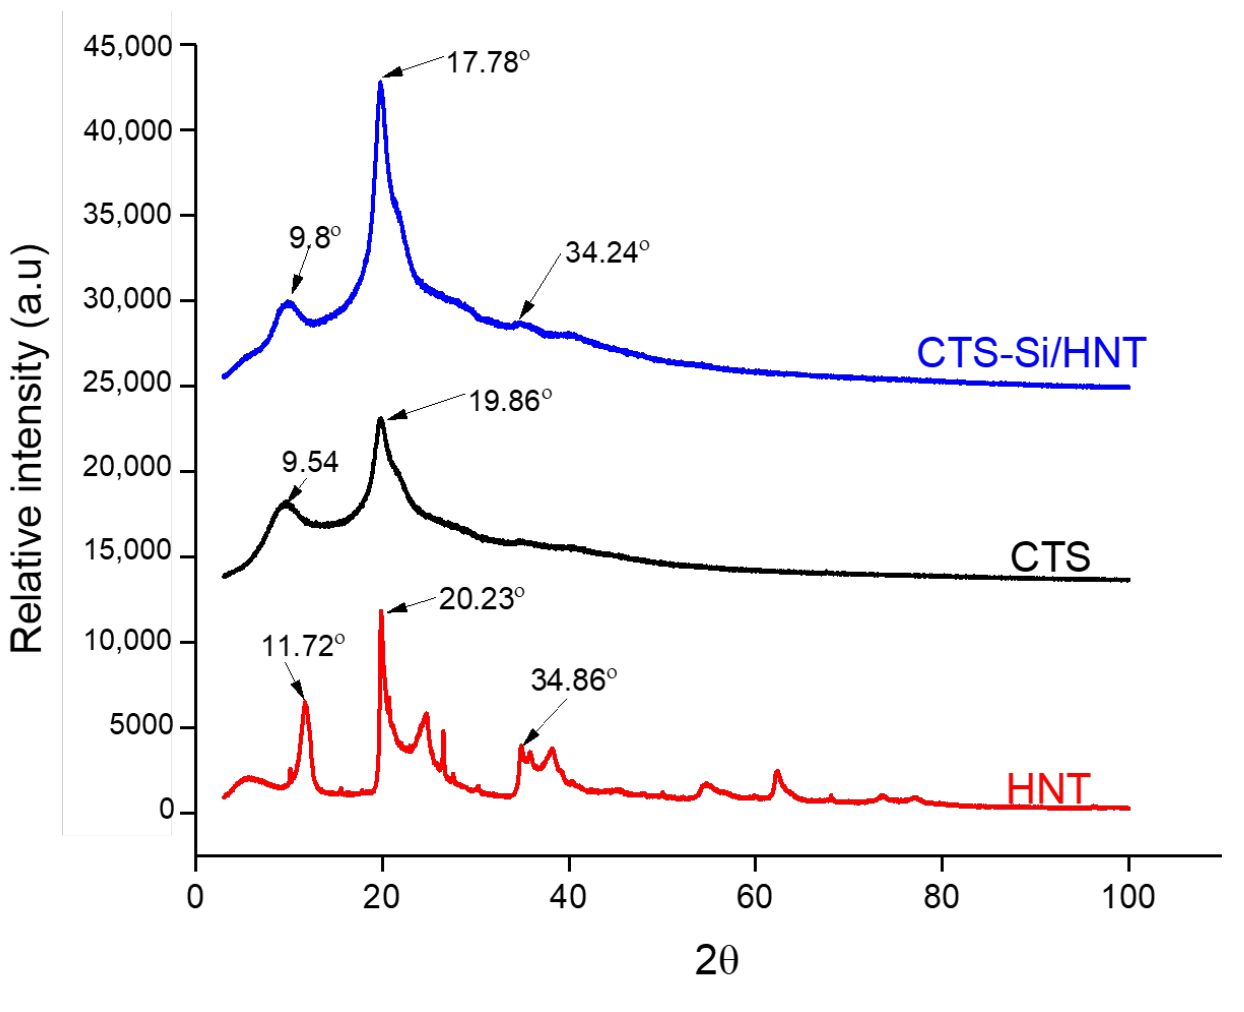
Figure 4. XRD diffraction of CTS-Si/HNT Nanocomposite, CTS-Si, and HNT.